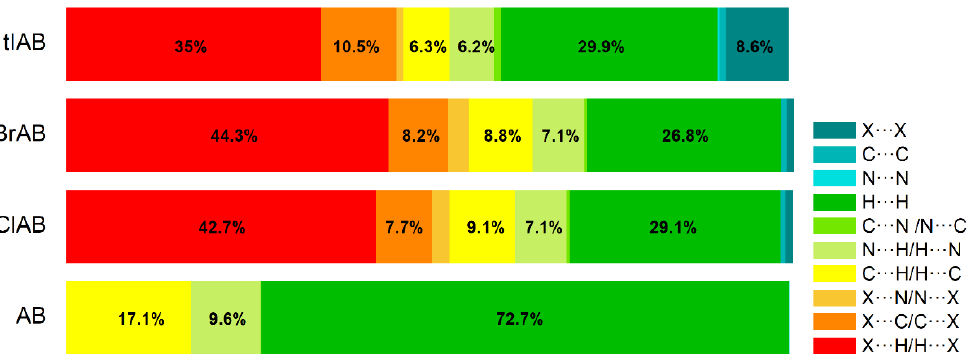
9 of 37 Table 5. A comparison of % of the Hirshfeld surface, total Hirshfeld surface and volume character- izing a set of compounds studied. Compoun d